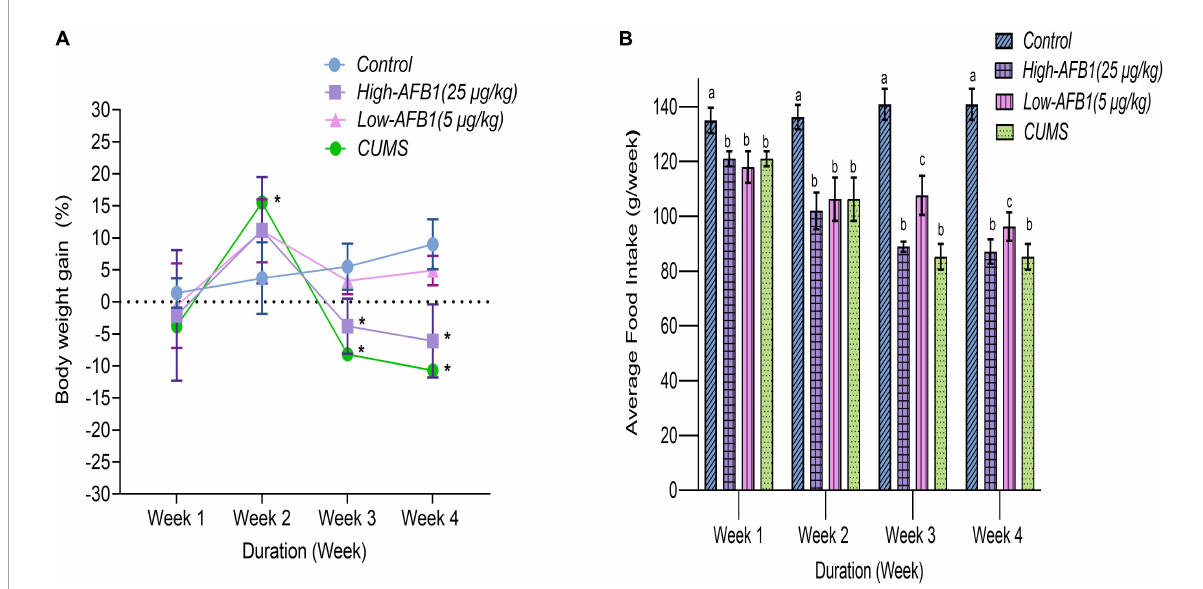
FIGURE1 Percentage of body weight gain (A) and average food intake in grams per week (B) of rats from four different groups during the treatment periods; Week 1 to 4 ( n = 8). Data are means from eight rats for each group (error bars indicate mean ± SD). In panel (A) , asterisk (*) indicates means between different groups within the same week with significant difference ( p < 0.05). In panel (B) , means between different groups within the same week with different lowercase letters (a, b) are significantly different ( p < 0.05).